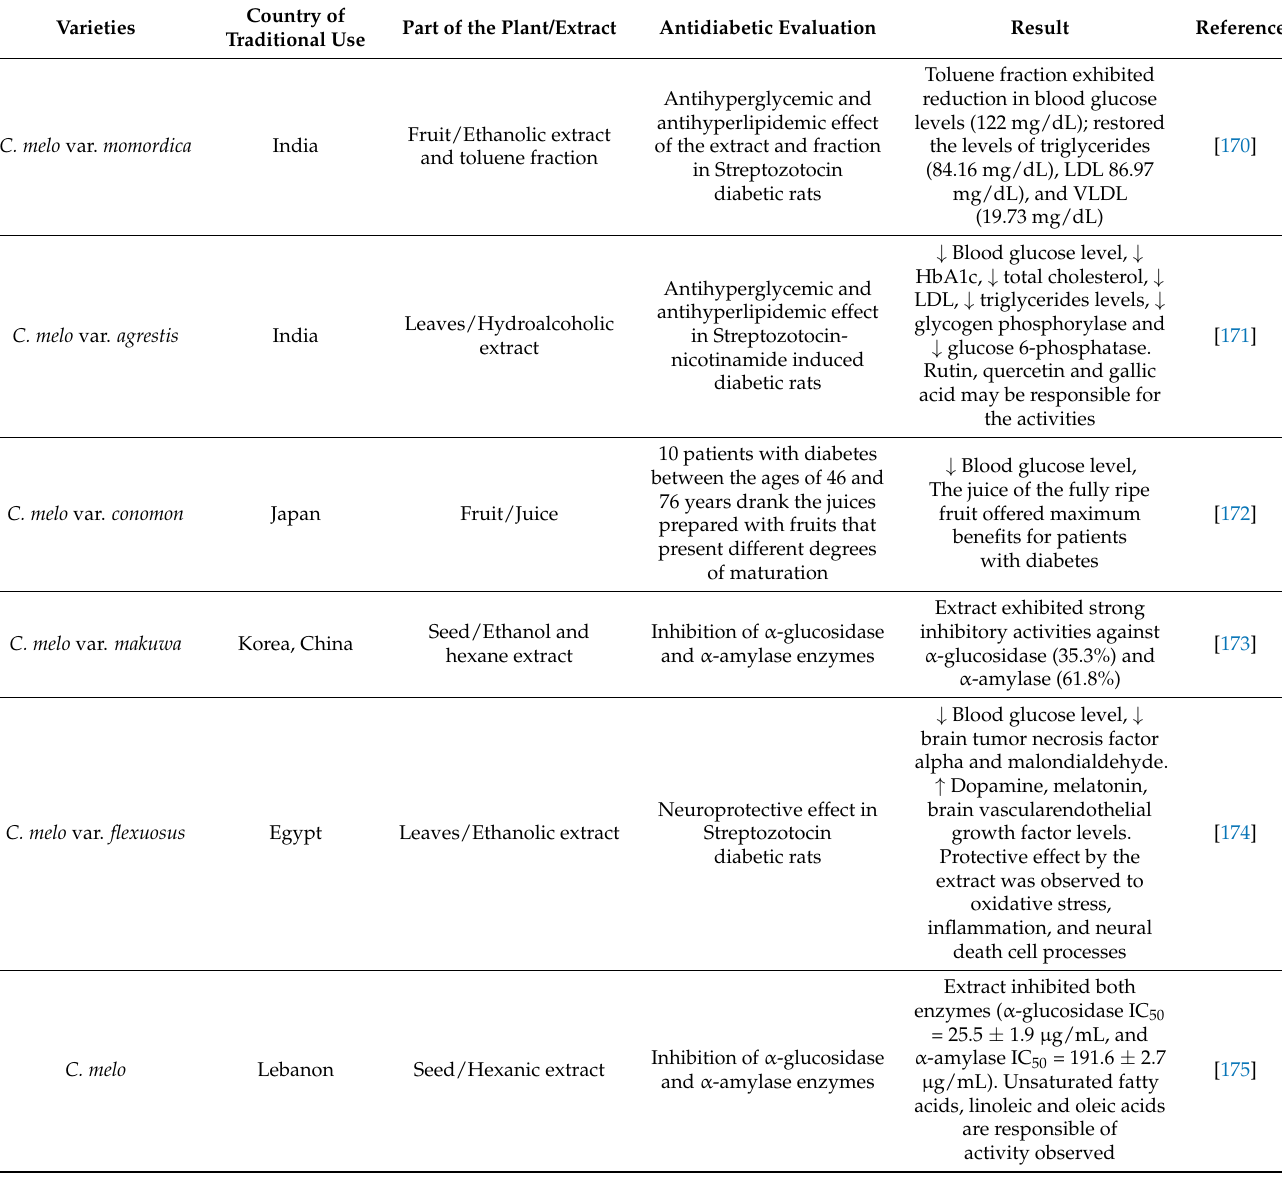
Table 4. Antidiabetic activities of commercial varieties of C. melo